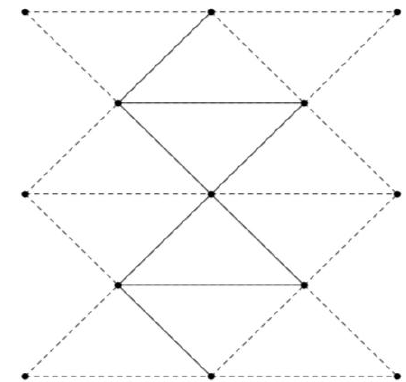
Figure 7. 5 × 5 nanosensor with ETL structure. Dashed lines do not benefit percolation when the electrical current can move in all